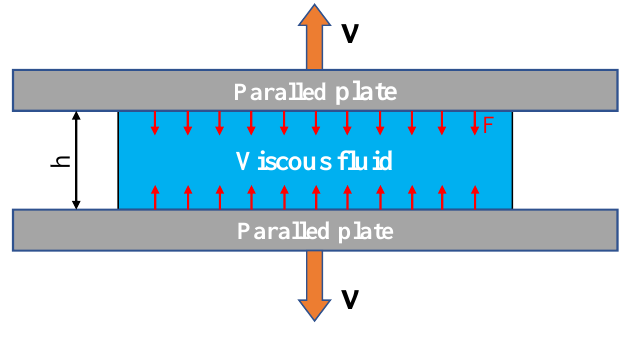
Figure 7. Stefan effect.